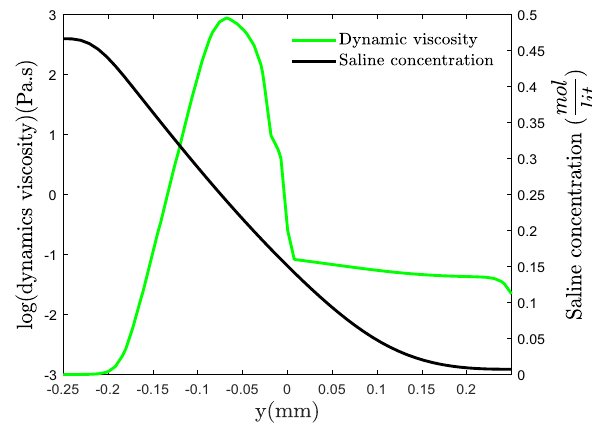
Fig. 4 Numerical method results comparison with the Experimen- tal Results by Bazargan et al. [24]. The velocity in each section is normalized to the maximum velocity in that section